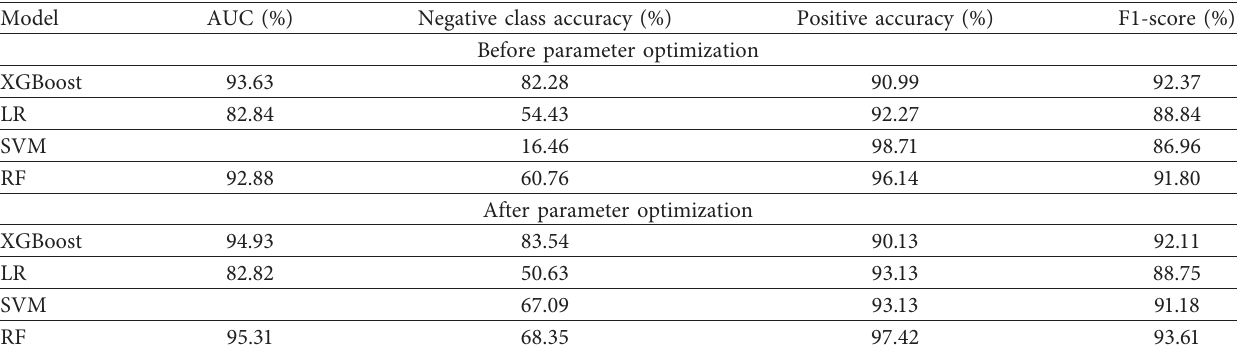
Table 9: Classification index value of each model before and after tuning.